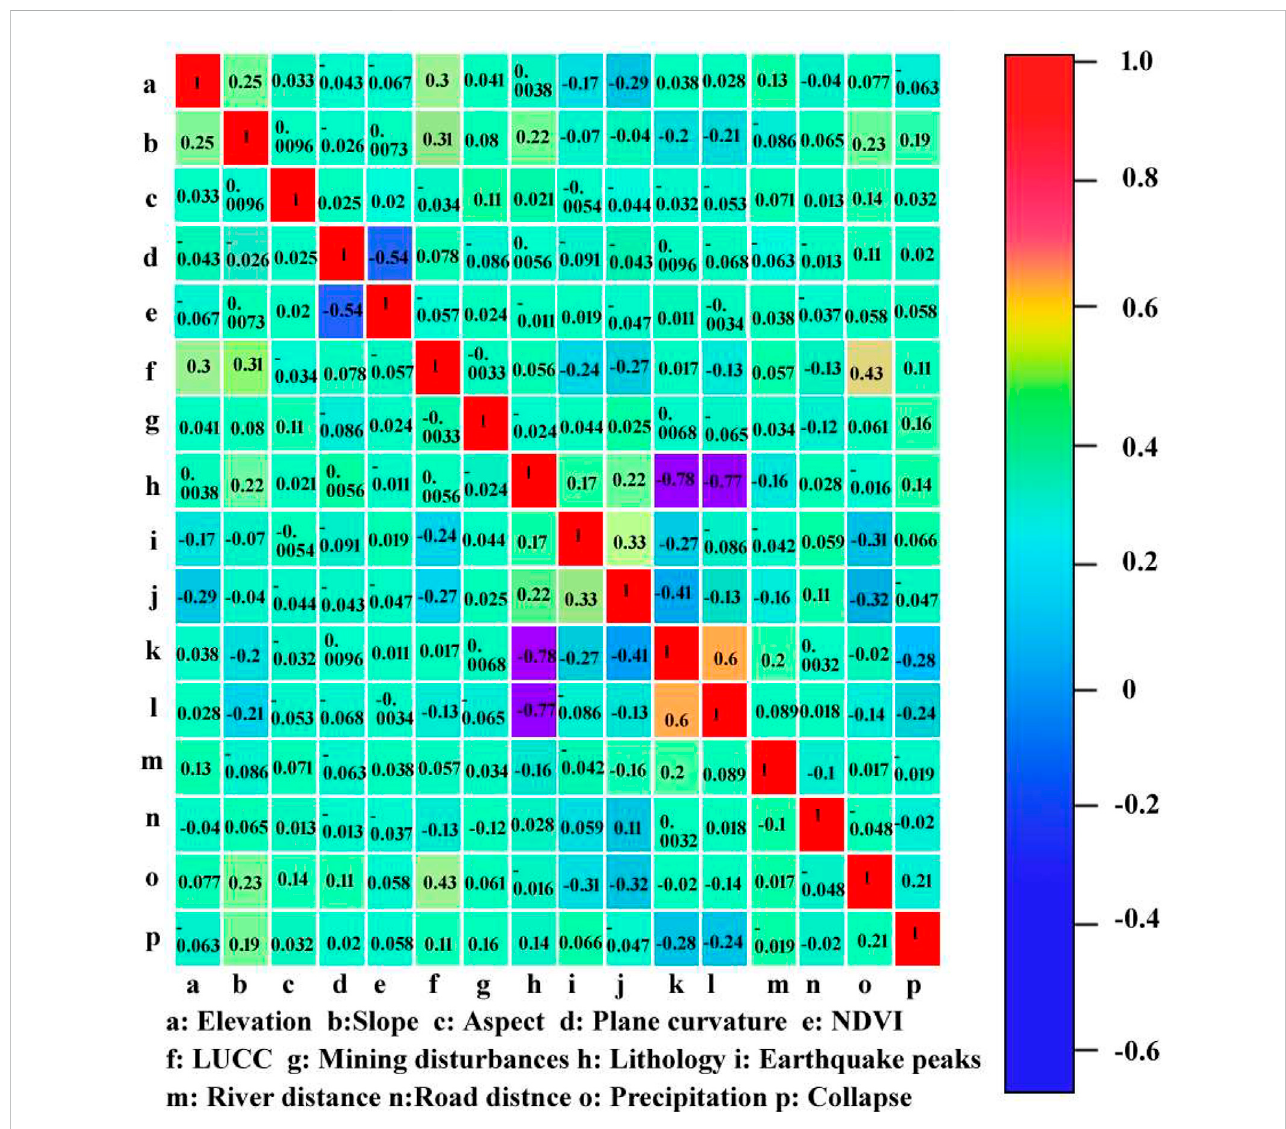
FIGURE 4 Pearson ’ s correlation coef fi cient plot for the 16 factors. (A) Elevation, (B) Slope, (C) Aspect, (D) Plane curvature, (E) NDVI, (F) LUCC, (G) Mining disturbances, (H) Lithology, (I) Earthquake peaks, (M) River distance, (O) Precipitation, (P) Collapse.